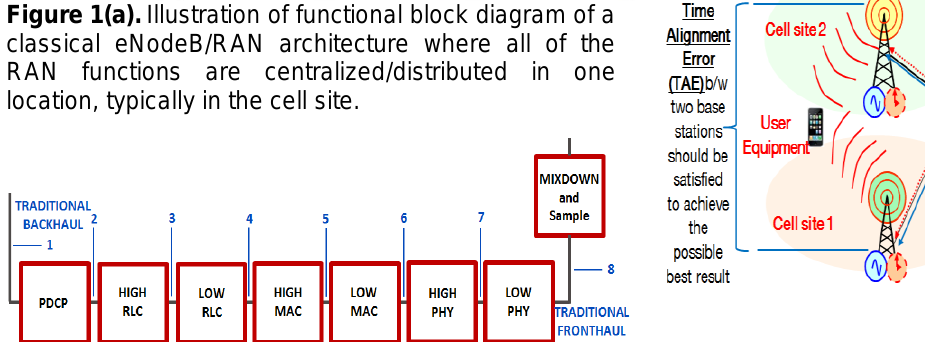
Figure 2. Illustration of synchronizing two wireless base station, where Time Alignment Error (TAE) between two base stations is crucial to obtain the best radio